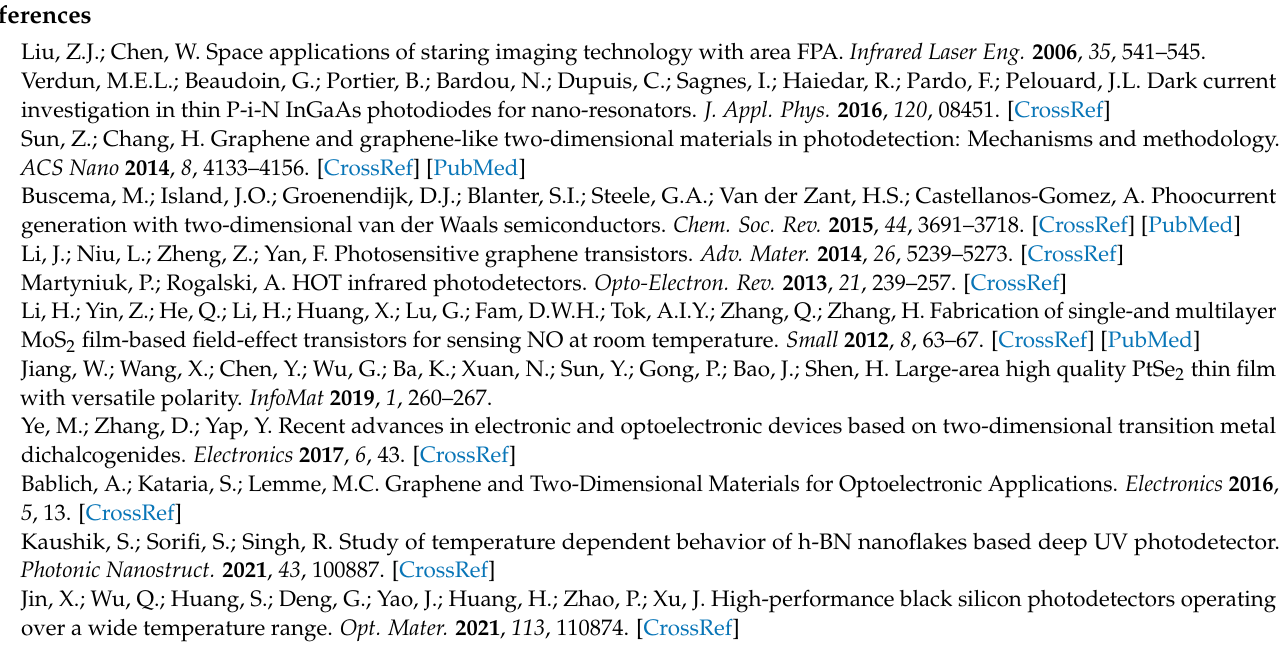
substrate; Figure S2. Pho-to-response performance of PtS 2 films based FETs at 532, 980, 1850 nm. ( a – c ) Photo-response of the device under different wavelengths of laser illumination under 532, 980 and 1850 nm as the power density decreased. ( d – f ) Photo-response of the photodetector to on/off laser illumination is 532, 980, and 1850 nm, respectively. ( g – i ) Photocurrent and responsivity as a function of laser il-lumination power density at 532, 980, and 1850 nm, respectively. ( j – k ) The power of incident light at 532, 980, 1850 nm and the detectivity ( D *) have a functional relationship, respectively; Figure S3. Photoelectric properties of PtS 2 nanosheets at high temperature. ( a ) Room temperature output characteristic curve of PtS 2 device 373 K. ( b ) The photocurrent changes at different laser wavelengths when the PtS 2 FET is heated to 373 K, and V ds = 2 V. At V ds = 2.0 V, the optical re-sponse changes with temperature when the PtS 2 device is heated to 373 K ( c ) and then reduced from 373 K to room temperature ( d